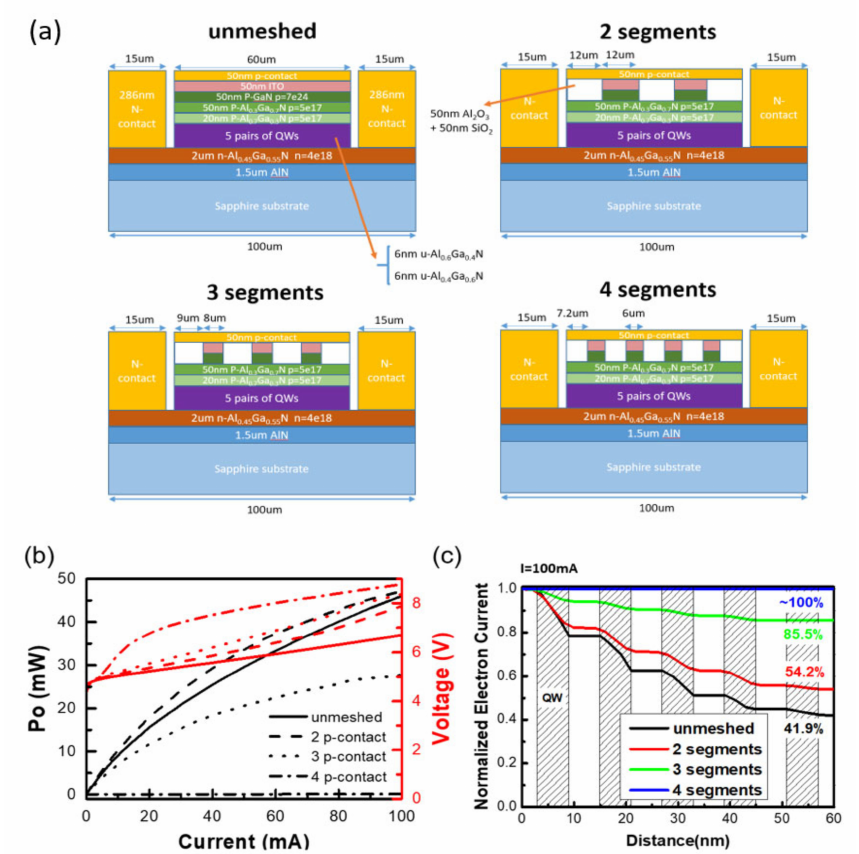
Figure 5. ( a ) Schematic diagrams of the simulated structures. ( b ) Simulated L–I–V characteristics